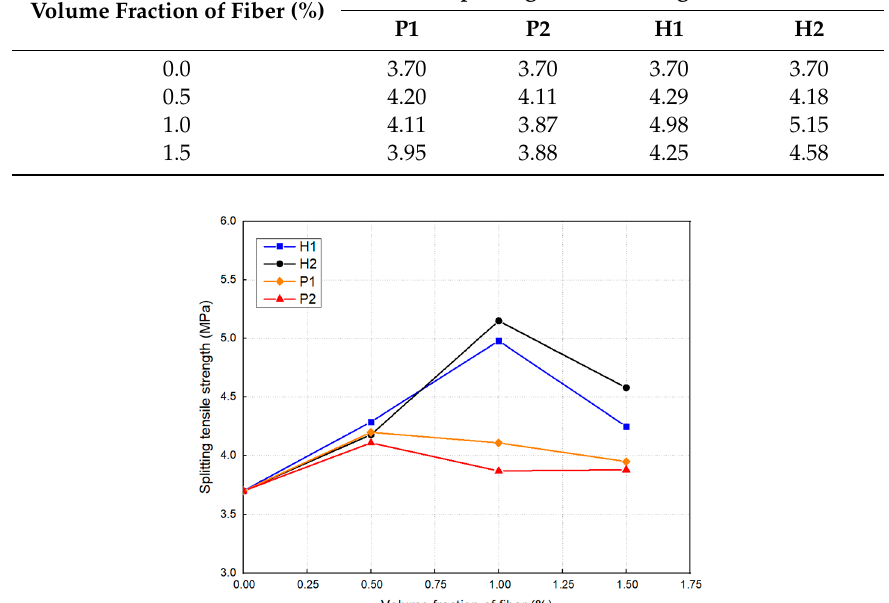
Table 8. Splitting tensile strength.